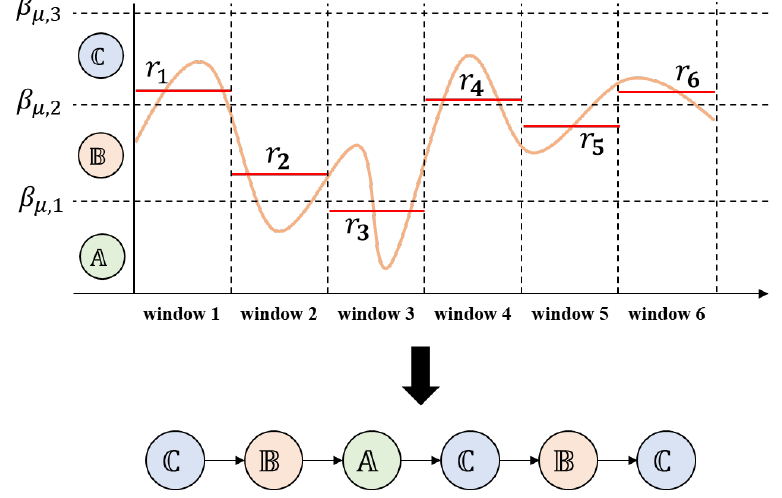
Figure 1. Symbolic aggregate approximation.